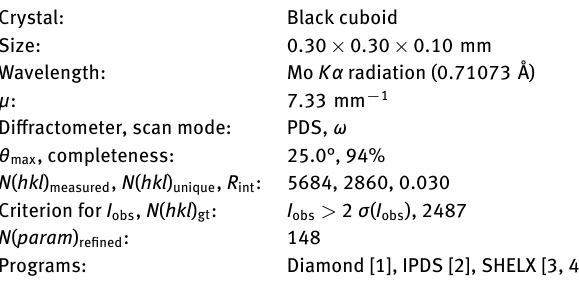
Table 1: Data collection and